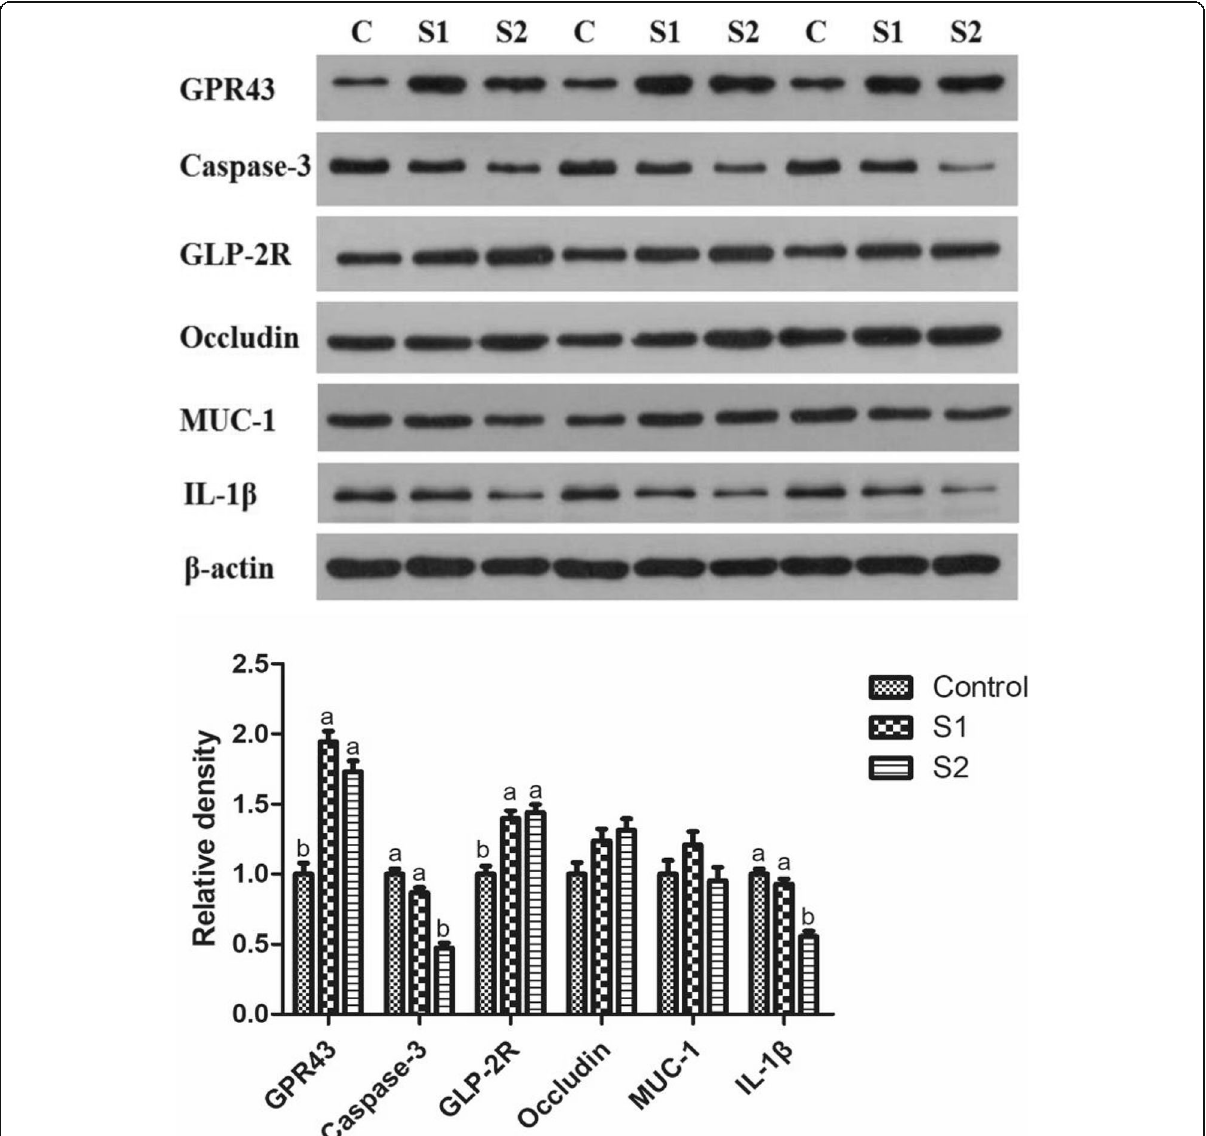
Fig. 8 Effect of gastric infusion of SCFA on the protein levels of GPR43, Caspase-3, GLP-2, Occludin, MUC-1, and IL-1 β in colon of weaned piglets. S1, pigs treated with SCFA (acetic, propionic, and butyric acids; 20.04, 7.71, and 4.89 mM respectively); S2, pigs treated with SCFA (acetic, propionic, and butyric acids; 40.08, 15.41, and 9.78 mM respectively). a, b, means without a common superscript differ ( P <